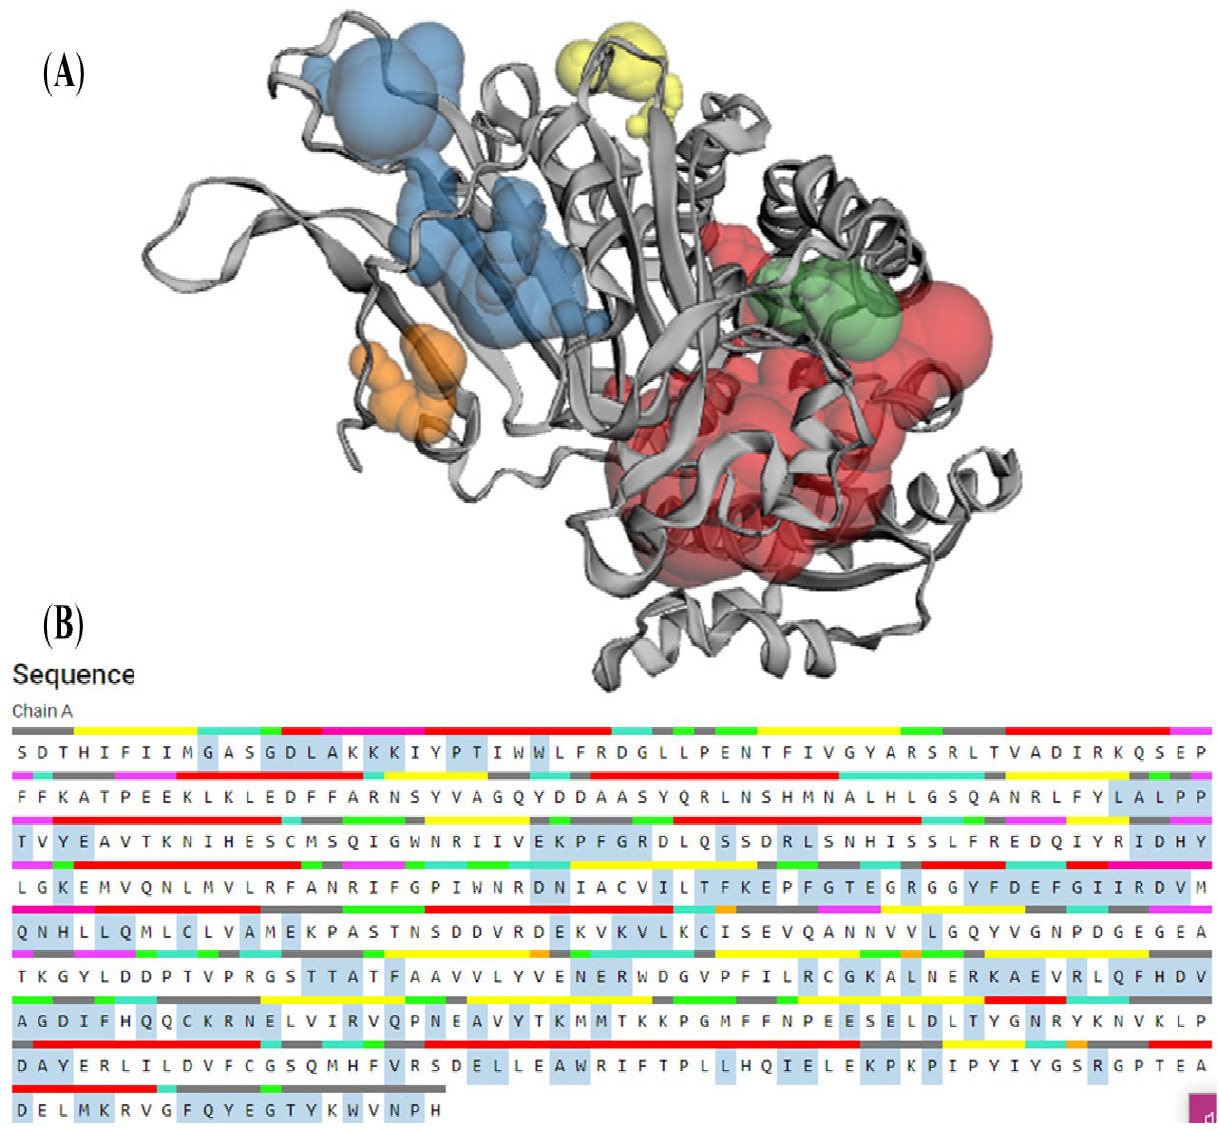
Table 6. Topological feature analysis by CASTp.